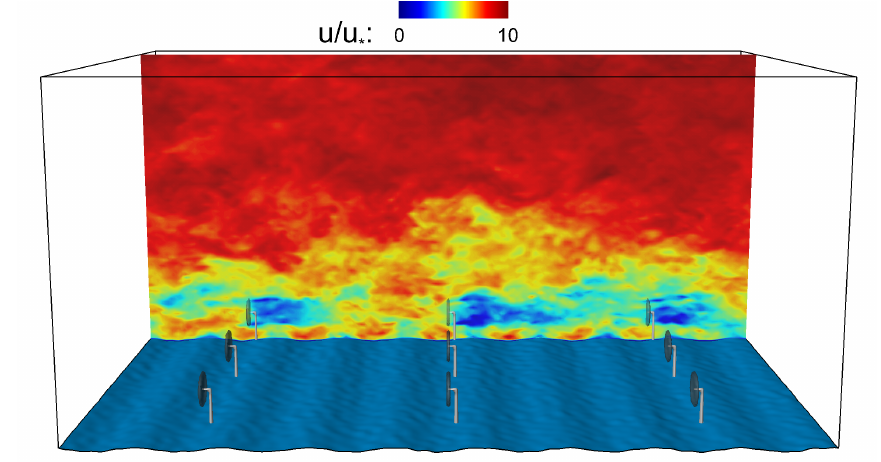
Figure 1. Illustration of three-dimensional instantaneous wind- and swell-wave fields in a fully developed offshore-wind-turbine array boundary layer. Contours of instantaneous streamwise wind velocity are plotted on the vertical plane across the center of the third column of turbines in the simulation domain. The turbine rotor disks are illustrated by the black circular disks representing where actuator-disk model forces are applied. The turbine towers and nacelles (shown in gray color) are also plotted only for illustration purposes, and their effects were not considered in the